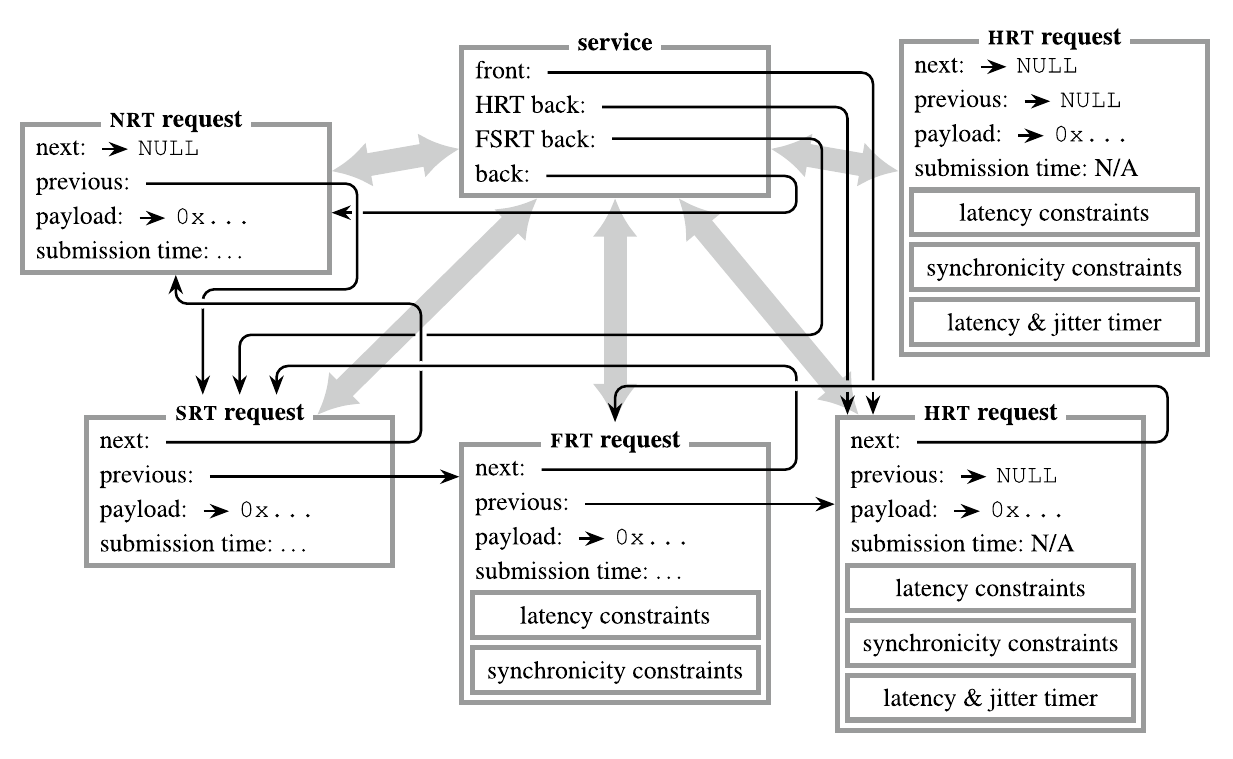
FIGURE 4 Visualization of an RPC interaction in µRT. Information is passed from request to service on submission and vice versa on response ( ). represent aggregations (i.e., pointers in C). An arbitrary number of requests may be submitted to a service , which buffers those in a queue, ordered by real-time class and constraints. The servicing thread dispatches one request at a time from the front of that queue, processes it, and returns a response (by reusing the original request instance). In the depicted situation, four requests are already enqueued at the service , whereas another HRT request is available but currently not in